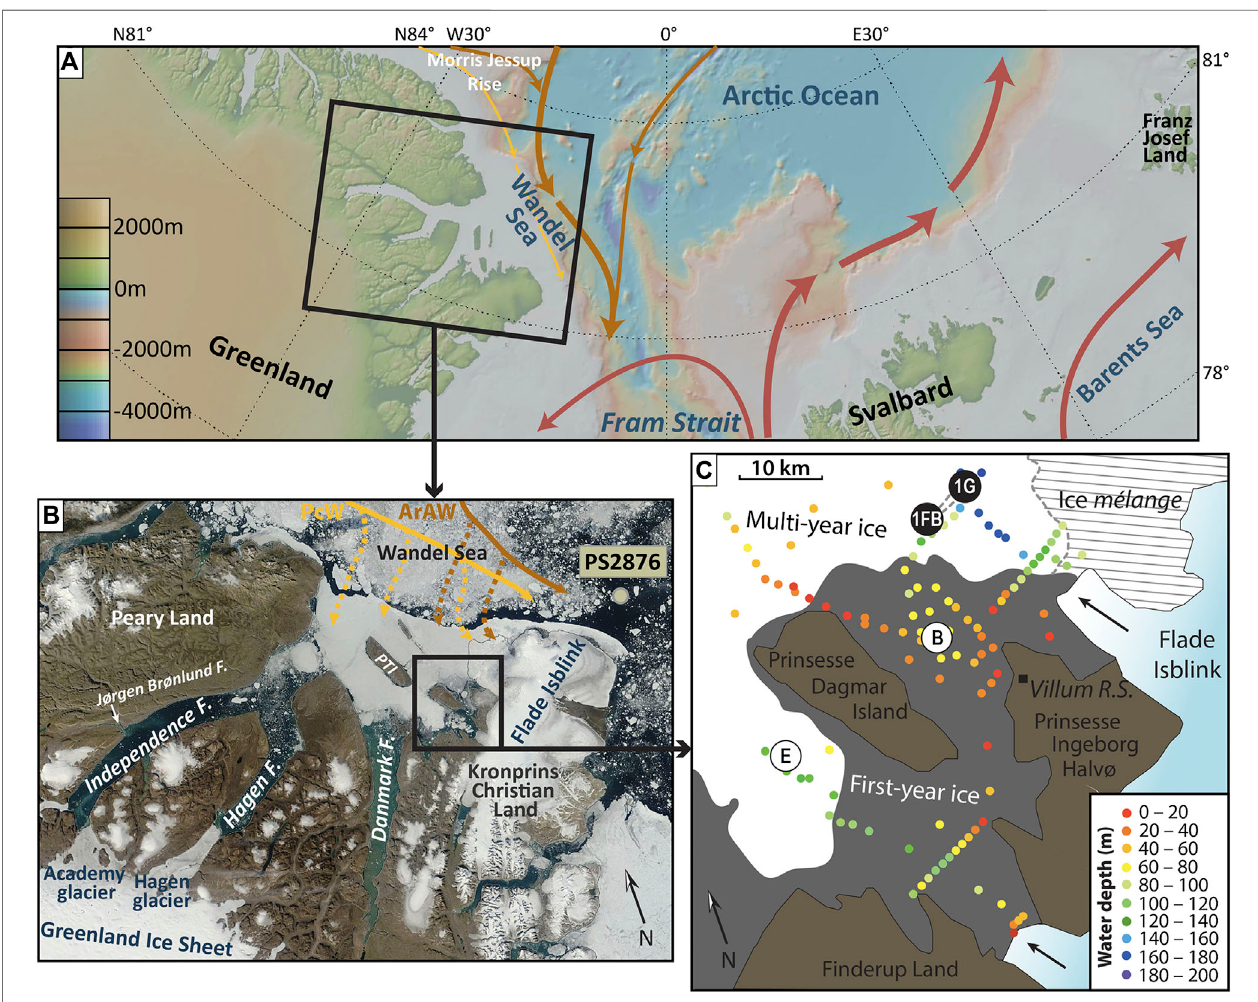
FIGURE 1 | (A) Map of the larger study area with its main surface currents. Red arrows indicate relatively warm and saline Atlantic water, orange arrows modi fi ed, Arctic-derived Atlantic water, and yellow arrows Paci fi c water. Basemap created using GeoMapApp (www.geomapapp.org)/CC BY/CC BY (Ryan et al., 2009). (B) Satellite image of the fjord system and ice cover around the study area (image from August 13, 2015; credit: NASA Worldview: https://worldview.earthdata.nasa.gov). Also shown are the location of core PS2876 just off the Wandel Sea shelf (Nørgaard-Pedersen et al., 2003) and the fl ow paths of Paci fi c water (PcW; yellow) and Arctic-derived Atlantic water (ArAW; orange) along and on the shelf (modi fi ed from Kirillov et al., 2017). PTI (cid:1) Prinsesse Thyra Island. (C) Detailed view of the study area aroundtheVillumResearchStationatStationNord,showingthelocationofsites1Fb(coresK6andR1)and1G(coresK9andR3).AlsoshownarethelocationsofsitesE and B from Nørgaard-Pedersen et al. (2008). Arrows indicate the fl ow direction of the two main western outlet glaciers from the Flade Isblink icecap.